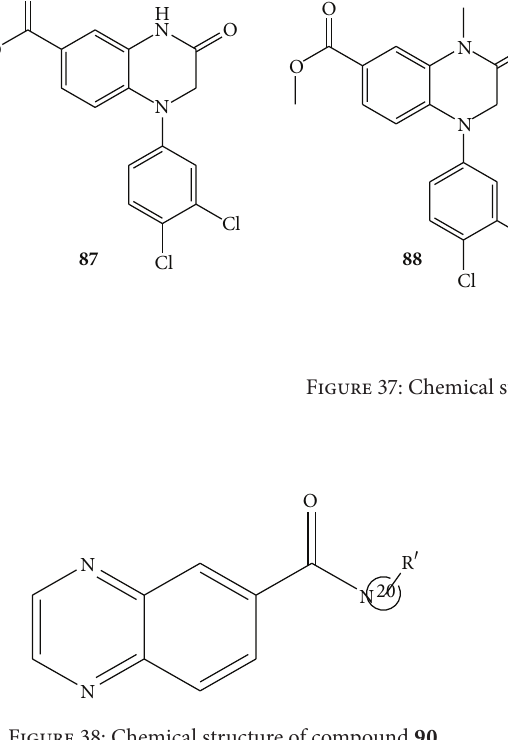
against wide number of bacterial species and also exhibited cytotoxic activity. Those drugs containing quinoxaline moiety are Carbadox and Brimonidine. Carbadox, a well-known synthetic antibacterial agent used for treatment of various bacterial diseases, and Brimonidines showed the importance of quinoxalines as a pharmaceutical agent as it palliates the symptoms of glaucoma through reducing intraocular